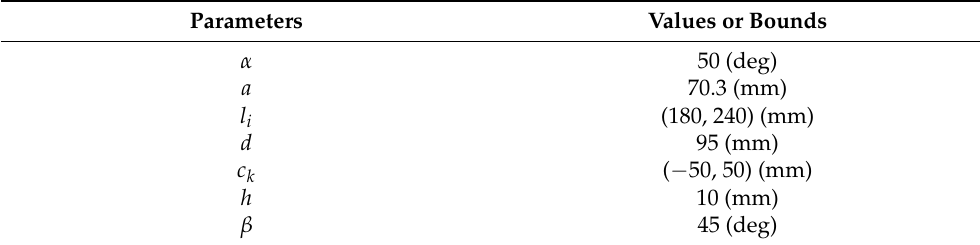
Table 1. Geometric parameters. Parameters Values or